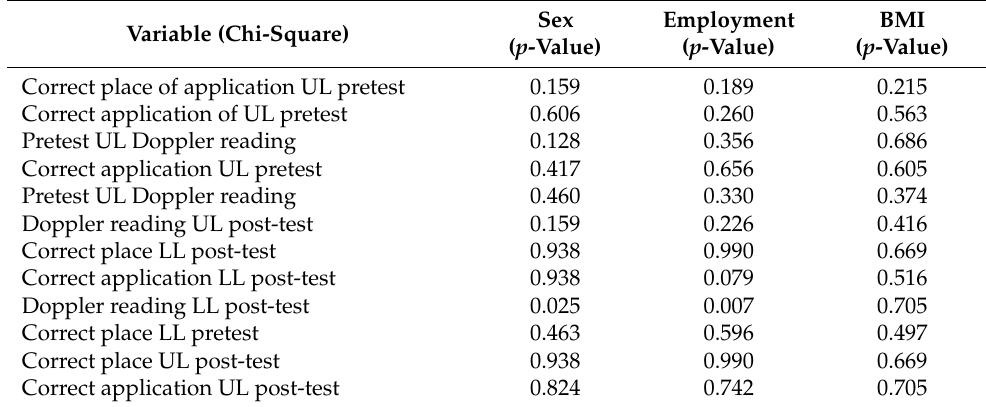
Table 2. Results by sex, military category (employment), and BMI. Values in bold denote statistical significance ( p < 0.05), Upper limb (UL), lower limb